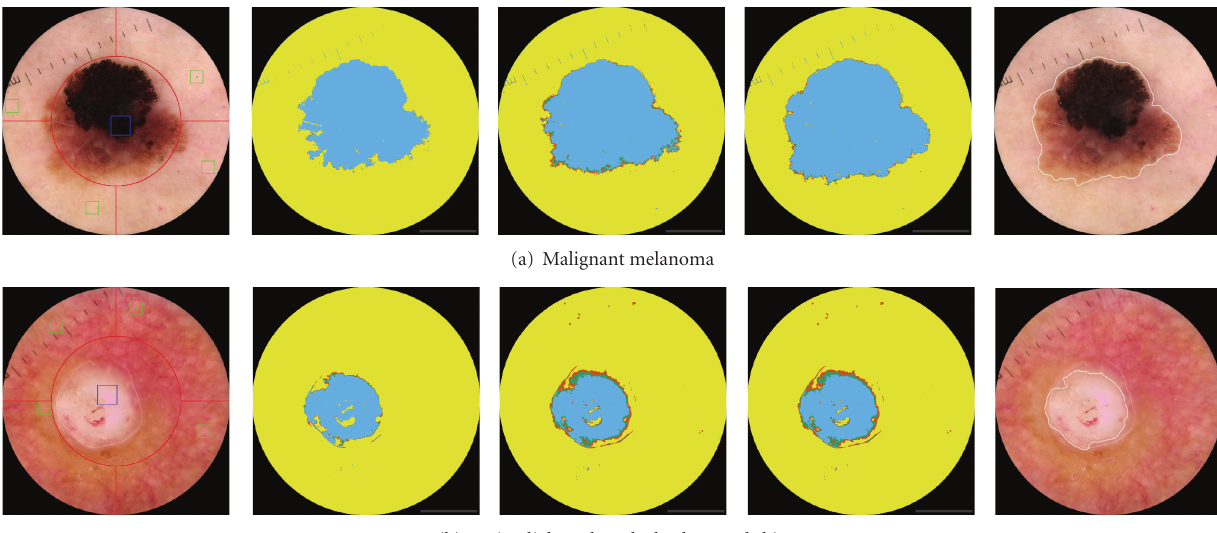
Figure 2: (Left) The small automatically selected green boxes correspond to the skin seed regions used as initial training. The location is based on the brightest luminance in each quadrant. The blue box corresponds to the seed region for the lesion, selected as the region statistically most di ff erent from the skin seeds. The three middle images show intermediate iterative steps at iterations j = { 1,2 } and the final iteration which is j = 7 in (a), j = 3 in (b). In these maps, yellow and blue pixels are those classified with high confidence as skin and lesion, respectively. The maps include also red and green pixels, corresponding to those pixels classified with low confidence as skin and lesion, respectively. The white contour in the rightmost figure is the final border obtained after